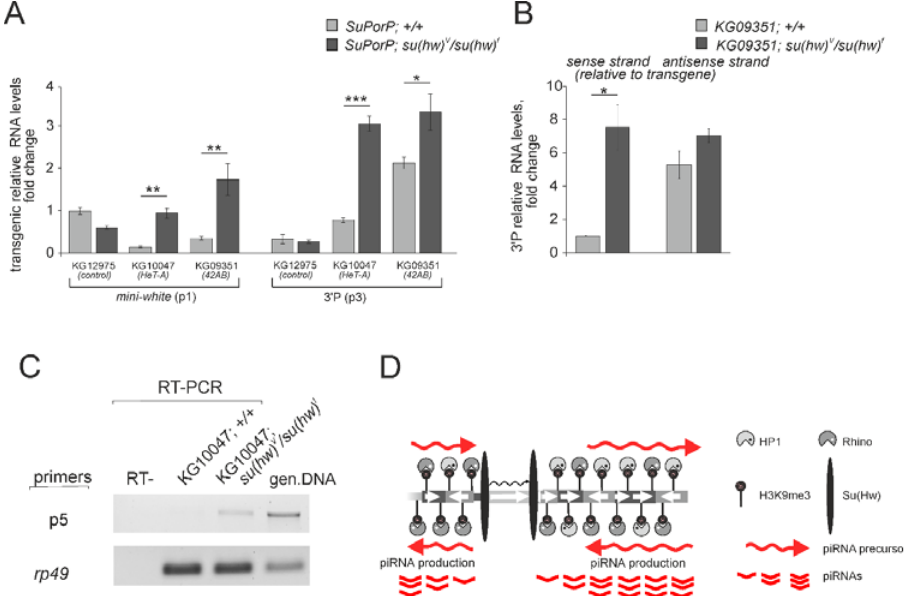
Figure 3. Transcription state of the transgenes containing Su(Hw) sites and located within piRNA clusters. The positions of primers are indicated in Figure 2A. ( A ) RT-qPCR analysis of transgenic mini-white and 3′ P transcripts in the ovaries of transgenic strains in wild type and Su(Hw) mutant backgrounds. The P1 primer pair used for RT-PCR specifically detects unspliced transgenic mini-white transcripts. ( B ) Strand-specific RT-PCR using the P3 primers corresponding to the transgenic 3′ P region showed a decreased level of RNA from sense but not from antisense transgenic strand downstream of the Su(Hw) binding sites. Asterisks indicate statistically significant differences in the expression levels between wild type and su(Hw) V /su(Hw) f mutants (* p < 0.05 to 0.01, ** p < 0.01 to 0.001, *** p < 0.001, unpaired t -test). ( C ) Agarose gel electrophoresis of RT-PCR products shows the presence of read-through transgenic transcripts comprising Su(Hw)-binding sites only in Su(Hw) mutants. Samples without reverse transcriptase were used as RT - controls. PCR on genomic DNA served as a positive control. ( D ) Scheme showing that insertion of the Su(Hw) insulator into the piRNA cluster disrupts local transcription of piRNA precursors, production of small RNAs and formation of specific chromatin structure.